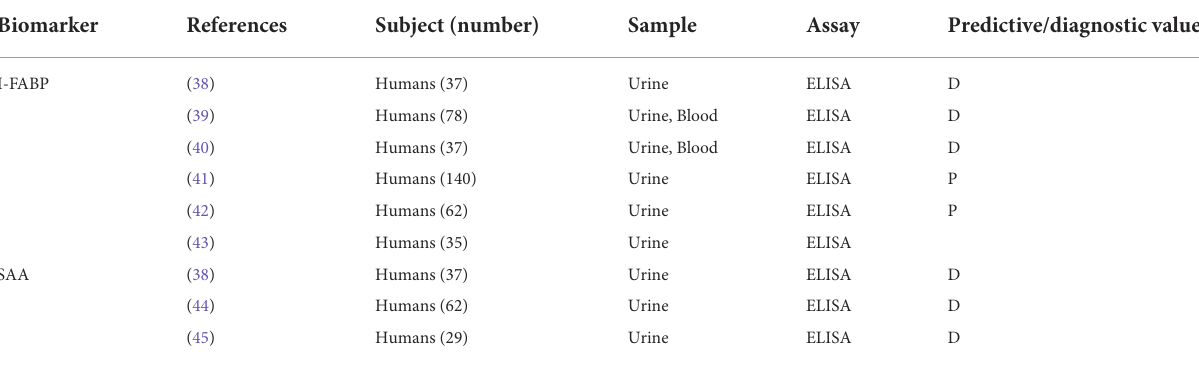
TABLE 2 Urine biomarkers of